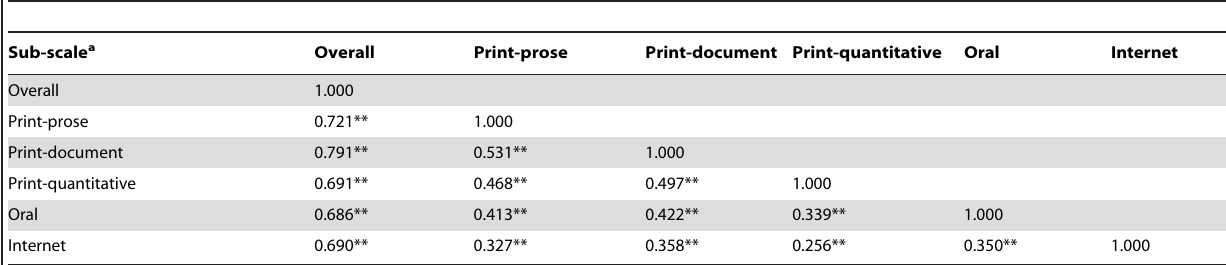
Table 4. Correlation coefficients of sub-scales of health literacy.